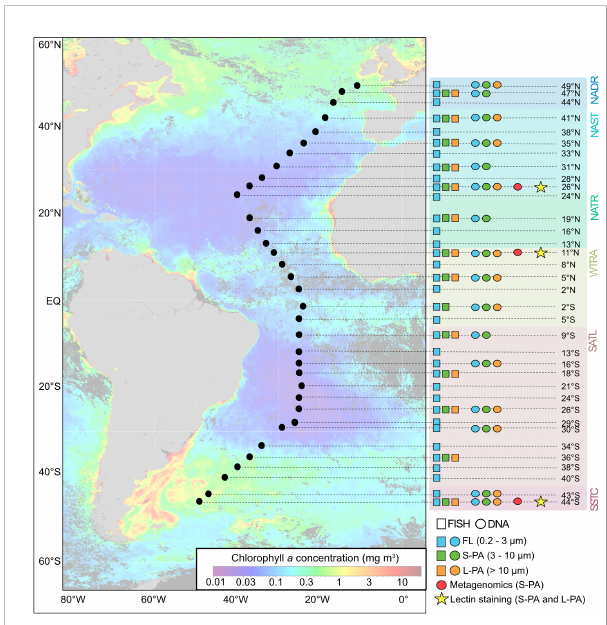
FIGURE 1 Sampling map and analysis list from AMT22. Map shows satellite- based chlorophyll a concentration during the time of sampling (Oct- Nov 2012) obtained from Aqua MODIS (Ocean Biology Processing Group, 2014). Stations are labeled according to latitude 49°N to 44° S and indicated as black dots across the map. Individual samples are shown in blue (FL), green (S-PA fraction), and orange (L-PA fraction) and indicate with FISH (boxes) and DNA (circles) analyses. Red dots indicate metagenomics samples from the S-PA fraction, stars indicate lectin staining from the S-PA and L-PA fraction. NADR North Atlantic Drift, NAST North Atlantic Subtropical, NATR North Atlantic Tropical Gyre, WTRA Western Tropical Atlantic, SATL South Atlantic Gyre, and SSTC South Subtropical